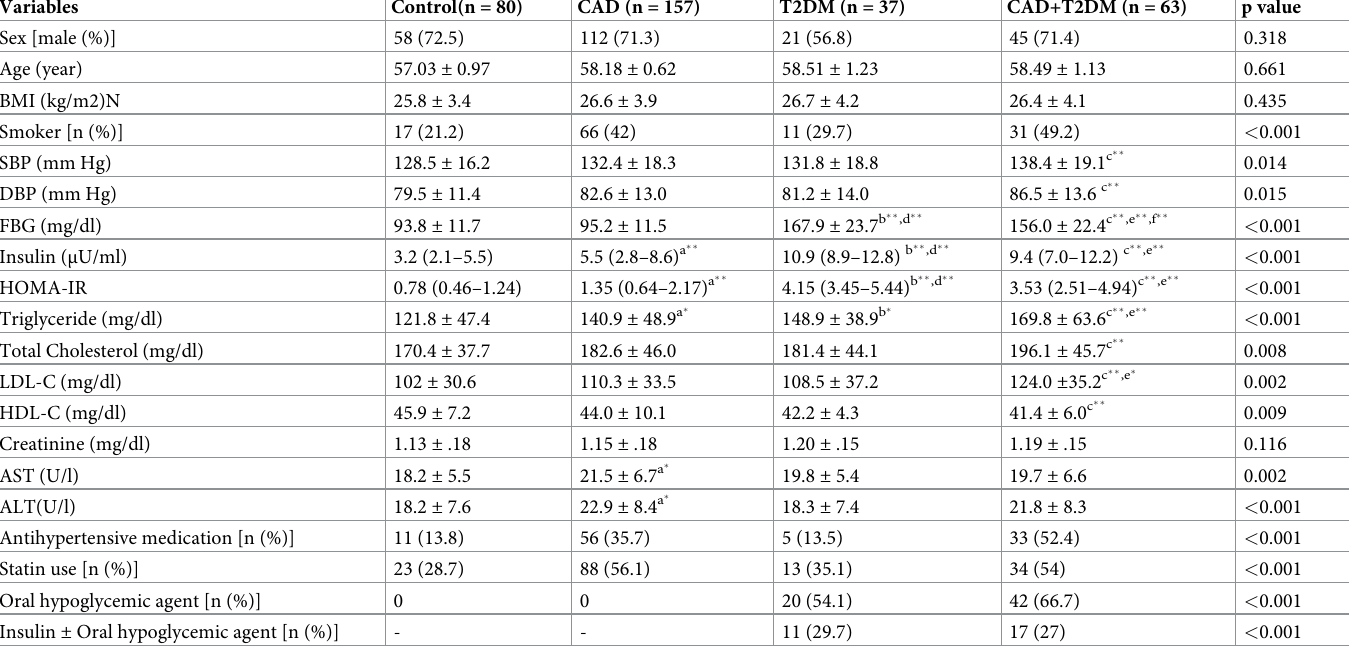
Table 1. Clinical and biochemical characteristics of study